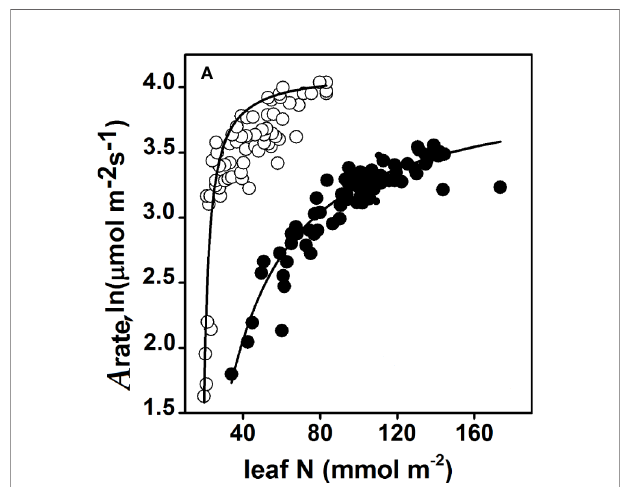
FIGURE 3 | Response of the CO 2 assimilation rate ( A rate ) to the same nitrogen content per unit leaf area in Zea mays (maize) (C 4 , white circle) and Oryza sativa (rice) (C 3 , black circle) plants. For the response of the nitrogen assimilation rate, A rate = 4.12, leaf N = 18.55, and R 2 = 0.78 (maize); A rate = 4.05, leaf N = 18.75, and R 2 = 0.91 (rice). The data collected for maize were from Sinclair and Horie, 1989 and Wong et al., 1985, and the data collected for rice were from Cook and Evans, 1983 and Makino et al., 1988. All responses were signi fi cant, and P -values arising from one-way ANOVA (Tukey ’ s test) analyses are presented. Statistical signi fi cance was de fi ned as P < 0.05. The complete detailed mentioned in Materials and Methods , Data Sources